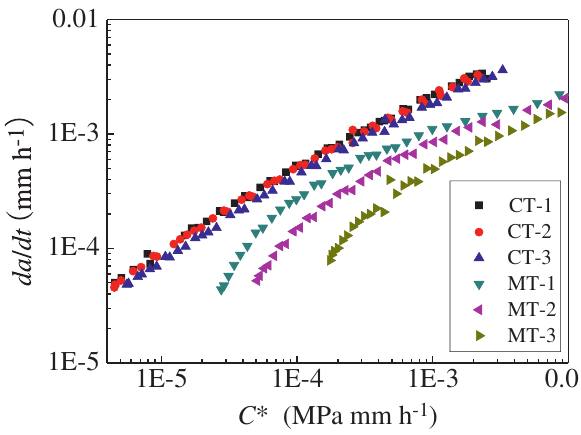
Figure 5: The da / dt – C * curves for M(T) and C(T) specimens with different material mismatches.